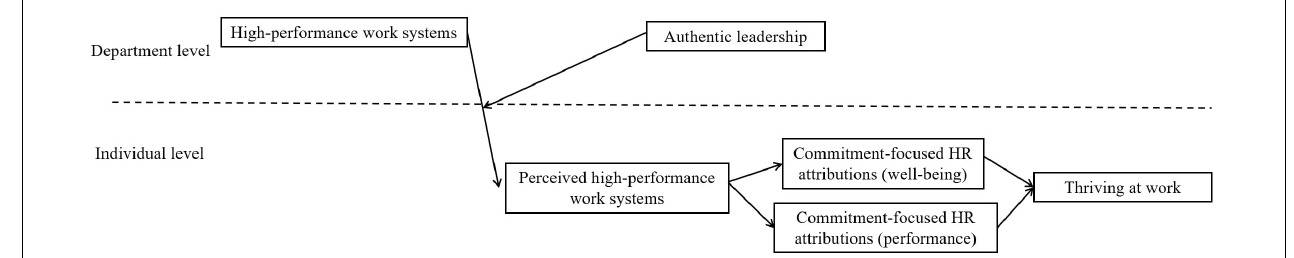
FIGURE 1 | Conceptual